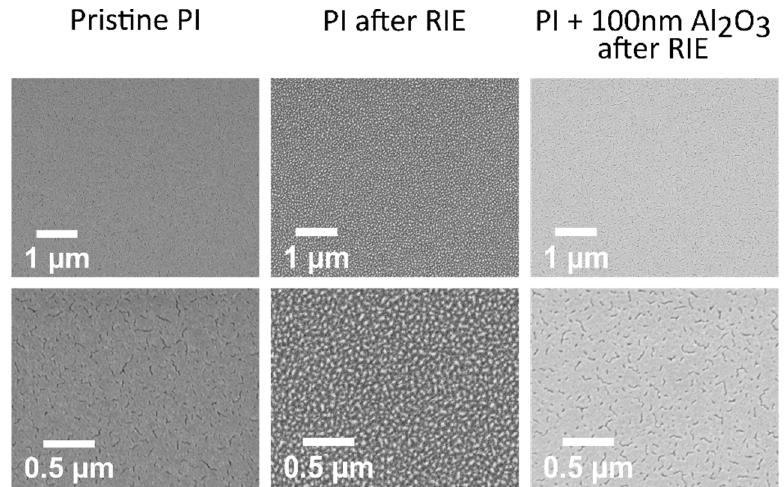
Figure 2. FEG–SEM images (magnification ×20,000 (top) and ×50,000 (bottom)) of pristine spin coated polyimide (PI), polyimide after the RIE process and polyimide with a closed ALD layer on top after the RIE process.